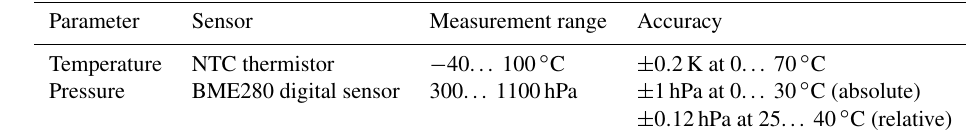
Table 1. Sensor specifications of APOLLO station (TE Connectivity, 2015; Bosch, 2020).